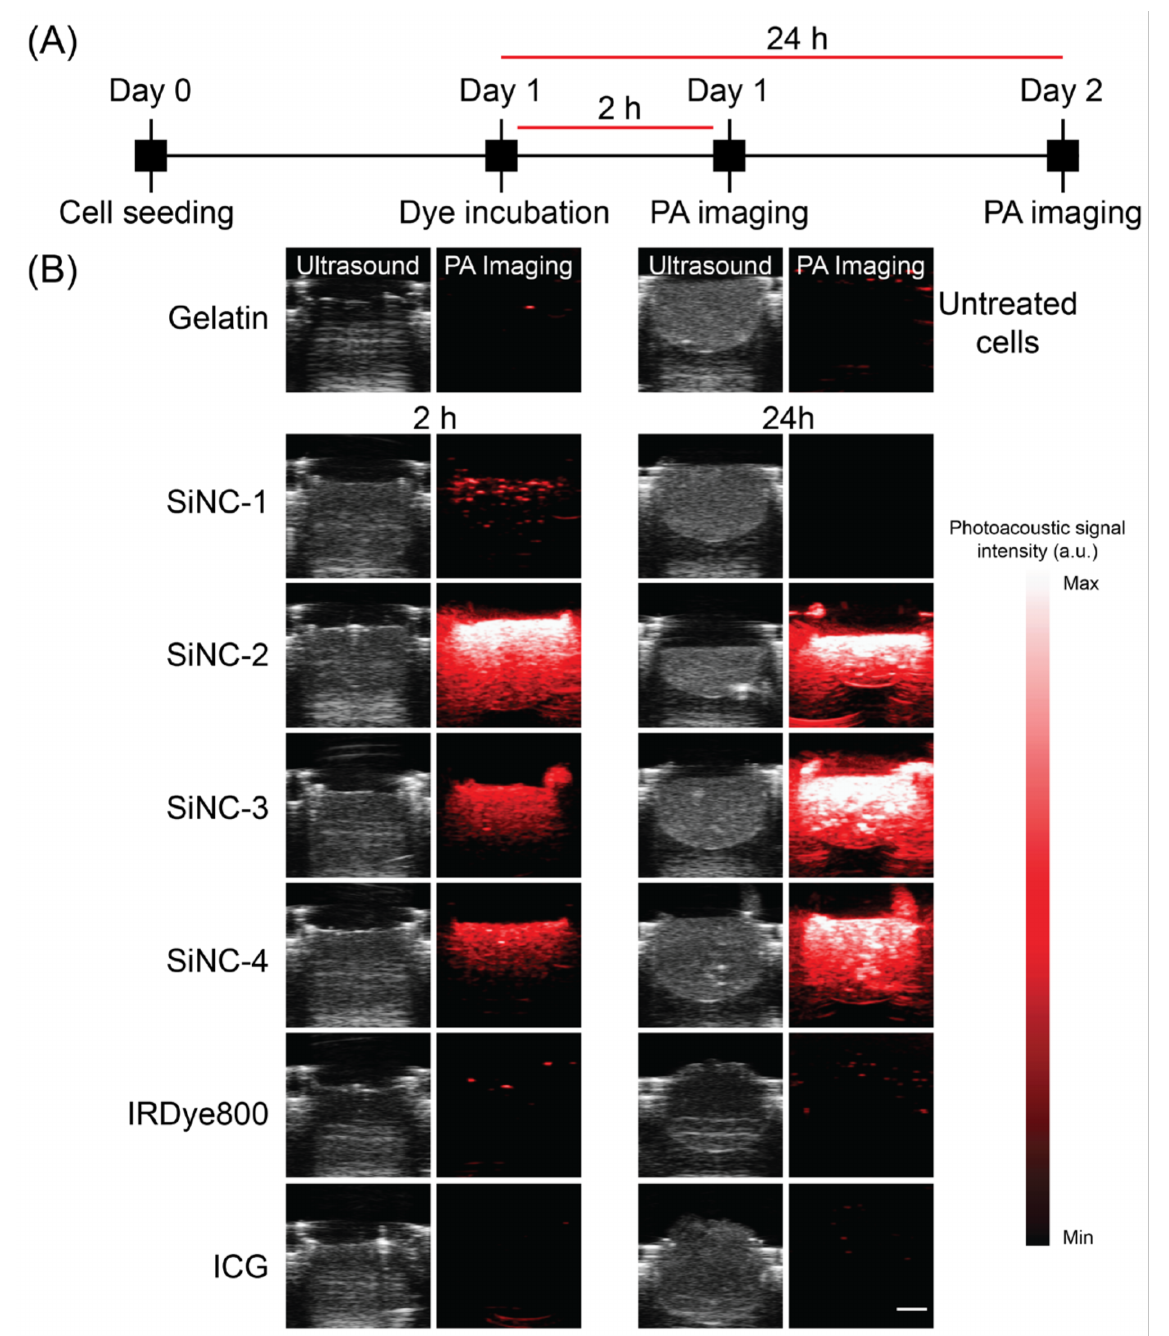
Figure 6. ( A ) Experimental scheme for photoacoustic imaging. ( B ) Ultrasound and photoacoustic images of Cal 27 tumor phantoms created after incubating the cells with different dyes at a concentra- tion of 2.5 µ M for either 2 h or 24 h. Phantoms created from gelatin and untreated cells were used as controls. Representative PA images of SiNC(1–4), IRDye800 and ICG treated cells recorded at 880 nm, 775 nm, and 780 nm, respectively, Scale bar represents 1 cm. Photoacoustic signal intensity (a.u.) bar is provided in the